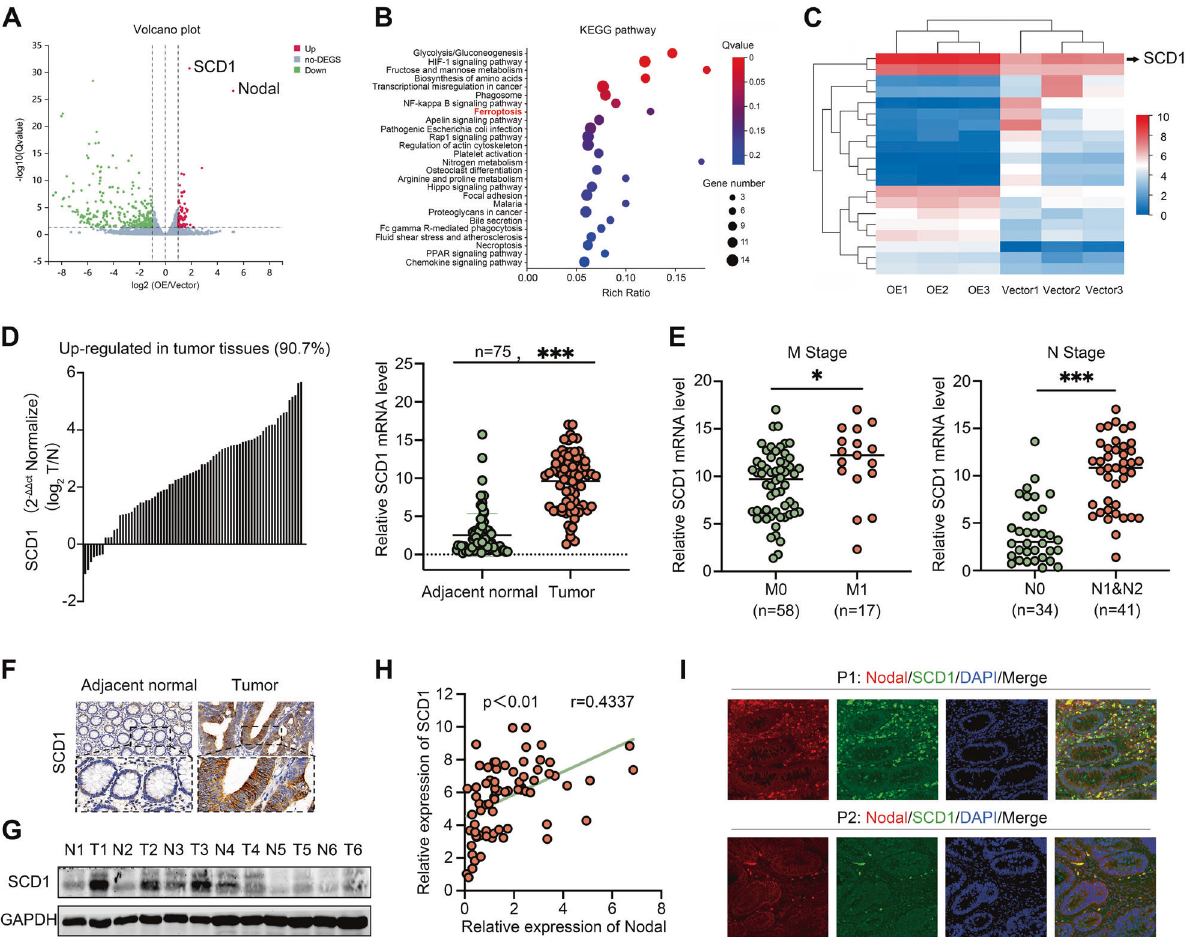
Fig. 3 SCD1 may be the potential downstream gene of Nodal. RNA-sequencing was performed using HCT116 cells stably overexpressing Nodal and control cells. The experiment was repeated thrice for each cell type. A Volcano map demonstrating the distribution of DEGs in HCT116 cells in the vector/oe-Nodal group. B Kyoto Encyclopaedia of Genes and Genomes (KEGG) enrichment analysis showed the signalling pathways that were most enriched by signi fi cantly differentially expressed genes. C Heatmap demonstrating the relative protein abundance. D The mRNA expression of SCD1 in 75 CRC tissues and their adjacent normal tissues was quanti fi ed via a qRT-PCR. E Correlation between SCD1 expression and the metastasis and node stages in the collected CRC samples. F Representative images of IHC staining for SCD1 in CRC tissues and their adjacent normal tissues (magni fi cation, × 200). G Western blotting was performed to examine the protein expression of SCD1 in six pairs of CRC tissues. H Pearson correlation analysis of the correlation between SCD1 and Nodal expression in the collected CRC samples. The relative expression level was calculated by using the 2 - △△ CT method. I Dual IF assay showed the expression and distribution of the SCD1 (green) and Nodal (red) in two CRC tissues (magni fi cation, 200×). ( ∗ P < 0.05 and ∗∗∗ P < used to establish a model of lung metastasis to evaluate the pro- metastatic ability of cells in vivo. Bioluminescent imaging indicated that Nodal signi fi cantly increased lung metastasis (Fig. 2M). These results indicate that Nodal promotes CRC cell growth and metastasis in vivo and in vitro. Knockdown of Nodal inhibited the proliferation and invasiveness of CRC cells in vitro SiRNA transfection successfully inhibited Nodal in SW620 and Lovo cell lines (Fig. S3A – C), and the fi rst siRNA was selected for the subsequent functional analysis. According to CCK-8 and colony formation assays, Nodal silencing inhibited Lovo and SW620 cell growth (Fig. S3D, E). Wound healing and Transwell assays demonstrated that Nodal silencing lowered SW620 and Lovo cell migration and invasion (Fig. S3F – G). According to IF analysis, most Lovo cells with Nodal silencing demonstrated an elevation in E-cadherin levels and a decrease in vimentin levels (Fig. S3H). Consistently, western blotting revealed that EMT was inhibited via Nodal silencing (Fig. S3I).